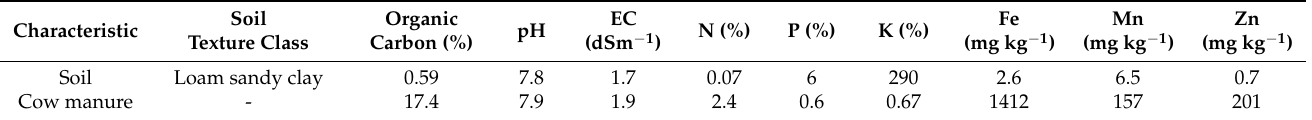
Table 1. Physico-chemical characteristics of soil and cow manure.